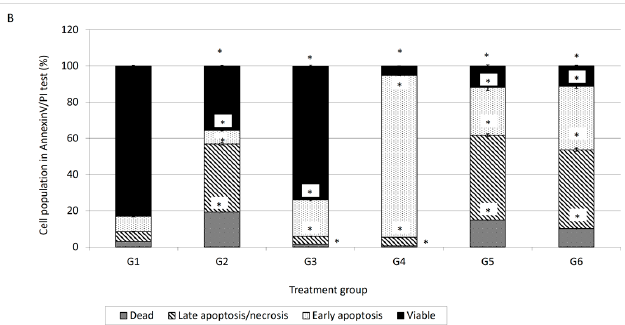
Figure 3. ( A ) Perturbations of cell cycle phase of MCF-7 cell after 72 h treatment; ( B ) FACS analysis